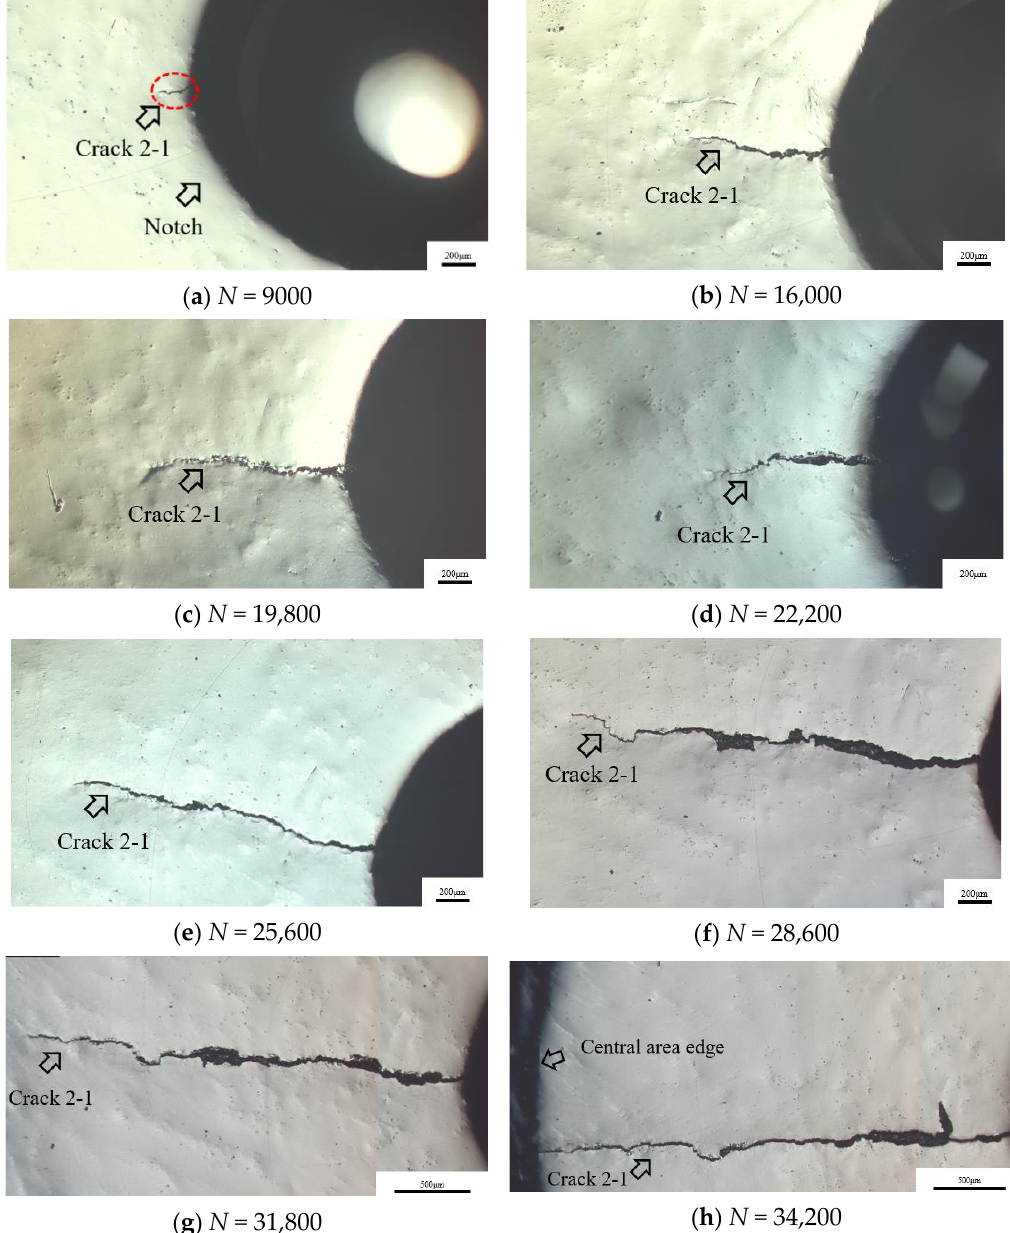
Figure 10. Crack 2-1 initiation and propagation process.